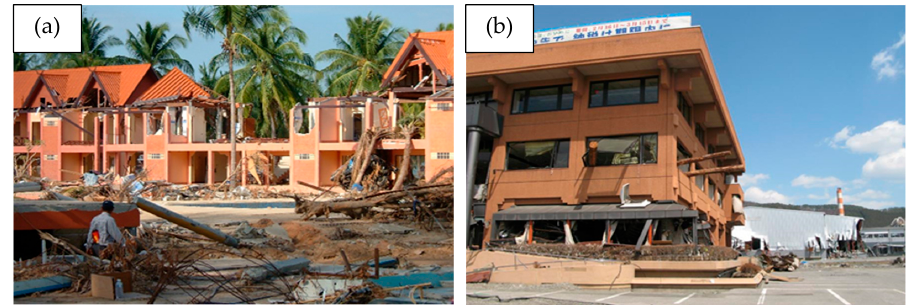
Figure 1. Damage from driftwood: ( a ) fallen trees collided against a hotel at Khao Lak in Thailand, and ( b ) some logs pierced the windows of a building at Ofunato in Japan.